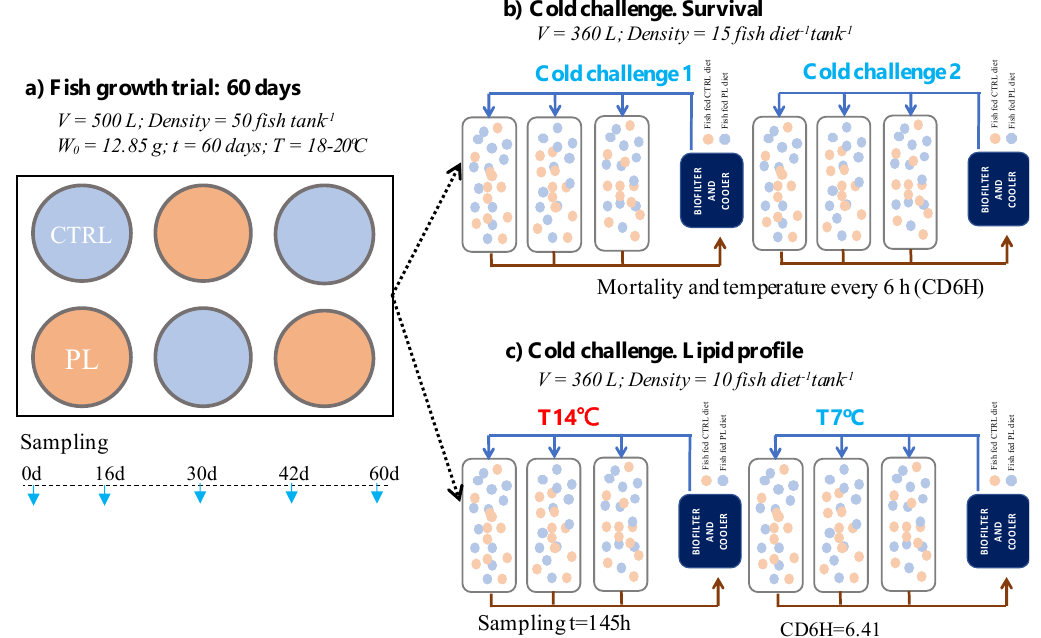
Figure 1. Overview of experimental design. ( a ) Scheme of the fish growth trial indicating the tanks fed with the control (CTRL, blue) or PL-enriched (PL, orange) diets. Average weight for fish, tank volume, fish densities and sampling days are shown; ( b ) scheme of cold challenge designs for survival analysis. Two challenges (1 and 2) were carried out. Tank volume and fish densities are shown. Mortality and temperature were recorded every 6 h to estimate the cumulative cooling degree-6hours (CD6H); ( c ) scheme of cold challenge to establish lipid profile in brain and liver. Sampling time, CD6H for T7 ◦ C treatment, tank volume and fish densities are